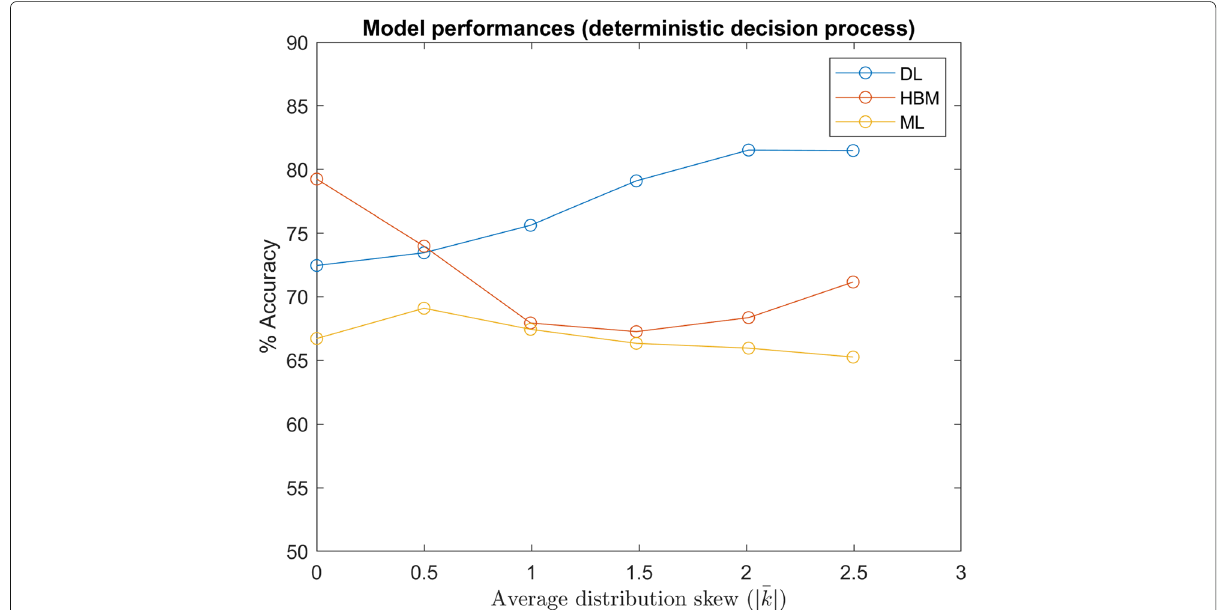
Fig. 16 Model Performances (Generated; Deterministic Process): Comparison of model performances (DL trained with 2,000 participants involved) over datasets with various underlying distributions of w , denoted by the approximate average of absolute shape factors k ( Gaussian distribution), as applied to the generalized, abstract data. In this test, decisions were simulated with the deterministic version of Eq. 2